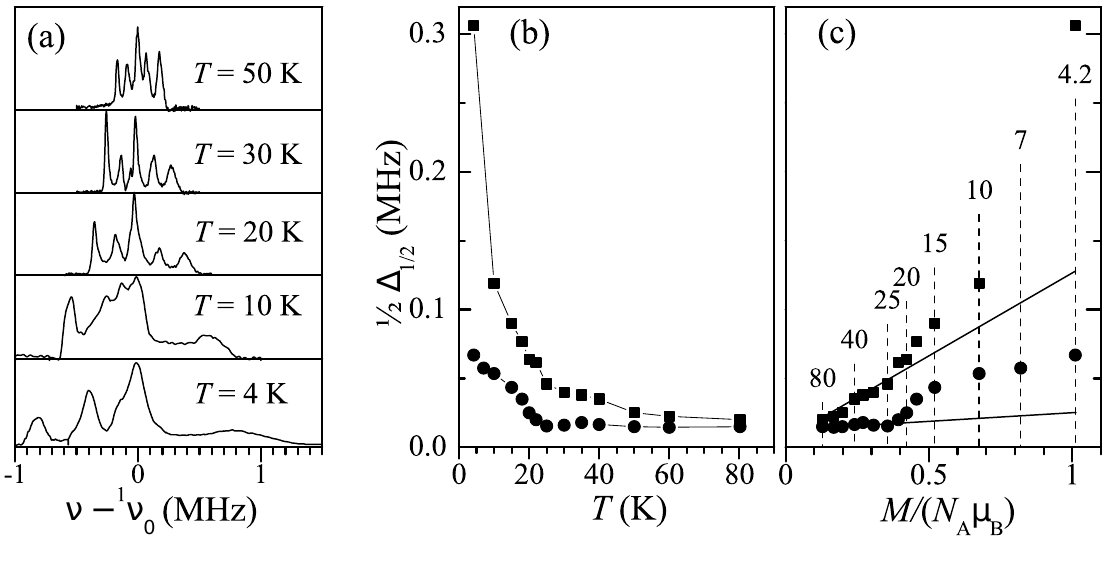
( a ) Temperature evolution of 1 H NMR spectrum measured at H parallel to ⃗a ∗ ; ( b ) Temperature dependence of the half-linewidth of the leftmost (circles) and the rightmost (squares) peaks; ( c ) The leftmost and the rightmost peak half-linewidths in function of the DC magnetization. Solid lines extrapolate the linewidth behavior above 25 K to low temperatures. Dashed lines with numbers on top mark measurement